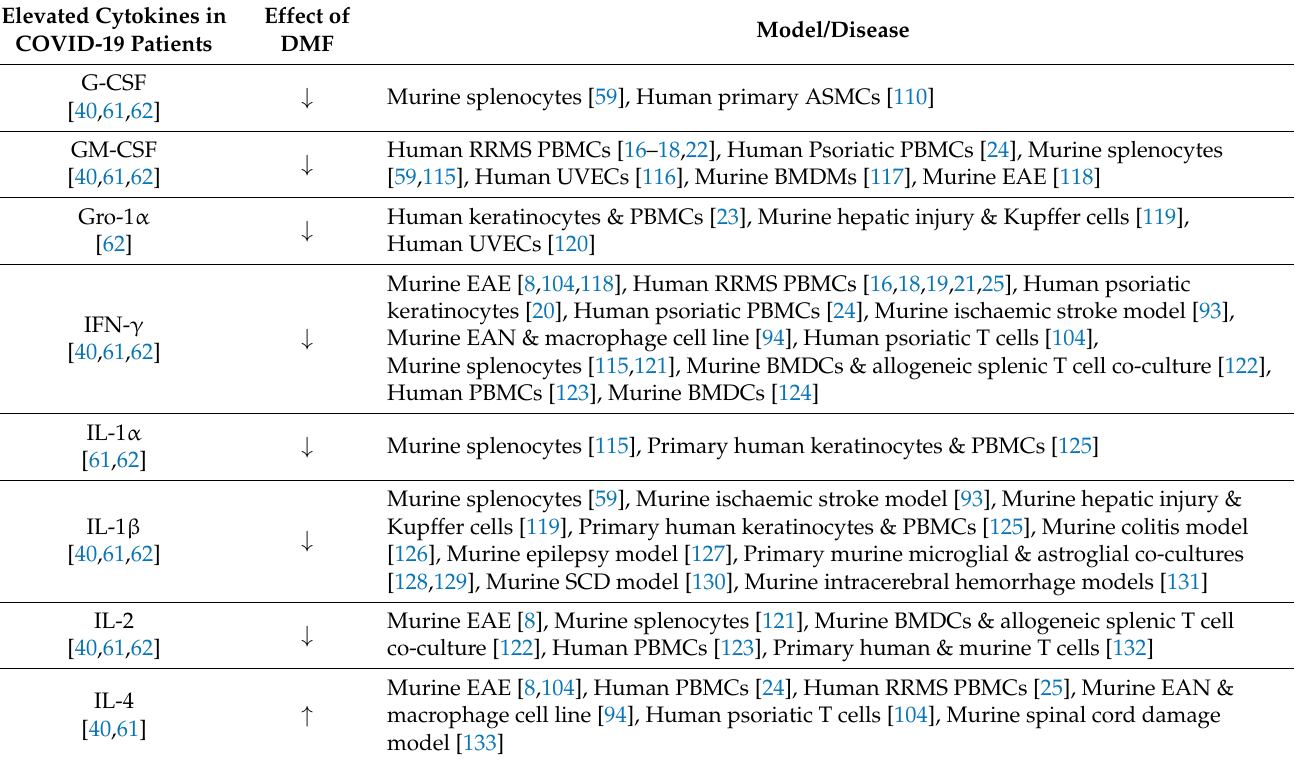
Table 2. Overview of the effect of dimethyl fumarate on cytokine